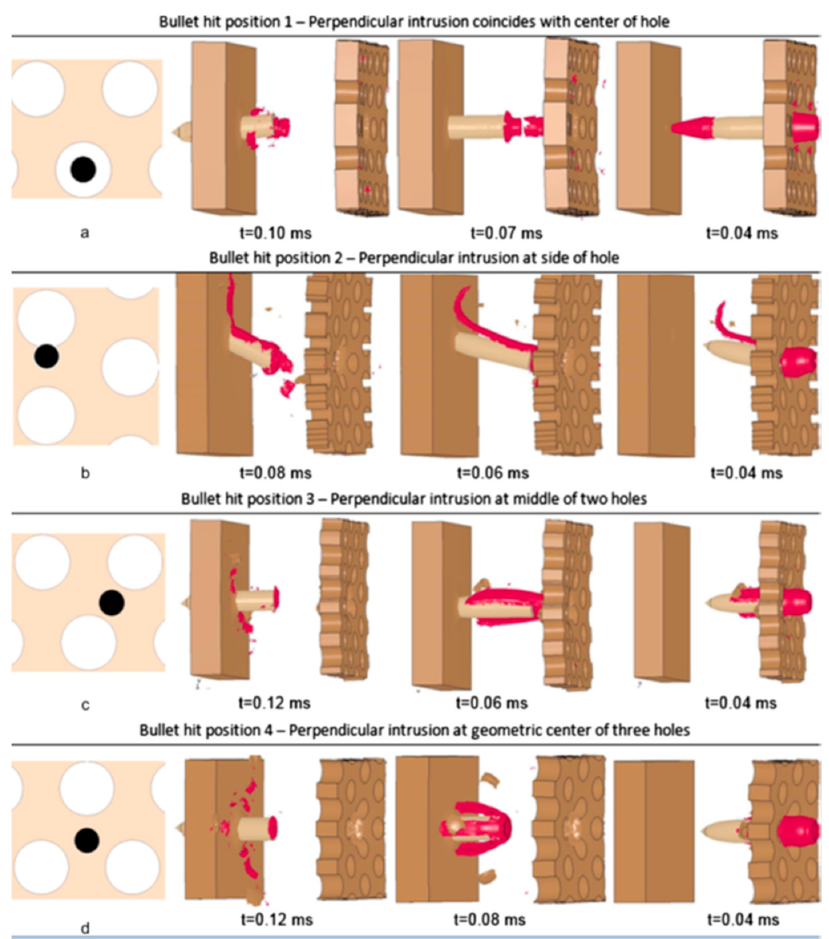
Figure 10. Projectile impacts in the perforated plate: ( a ) center of the hole; ( b ) hole side; ( c ) between two holes; ( d ) geometric center between three holes [44]. Reprinted with permission from Elsevier: